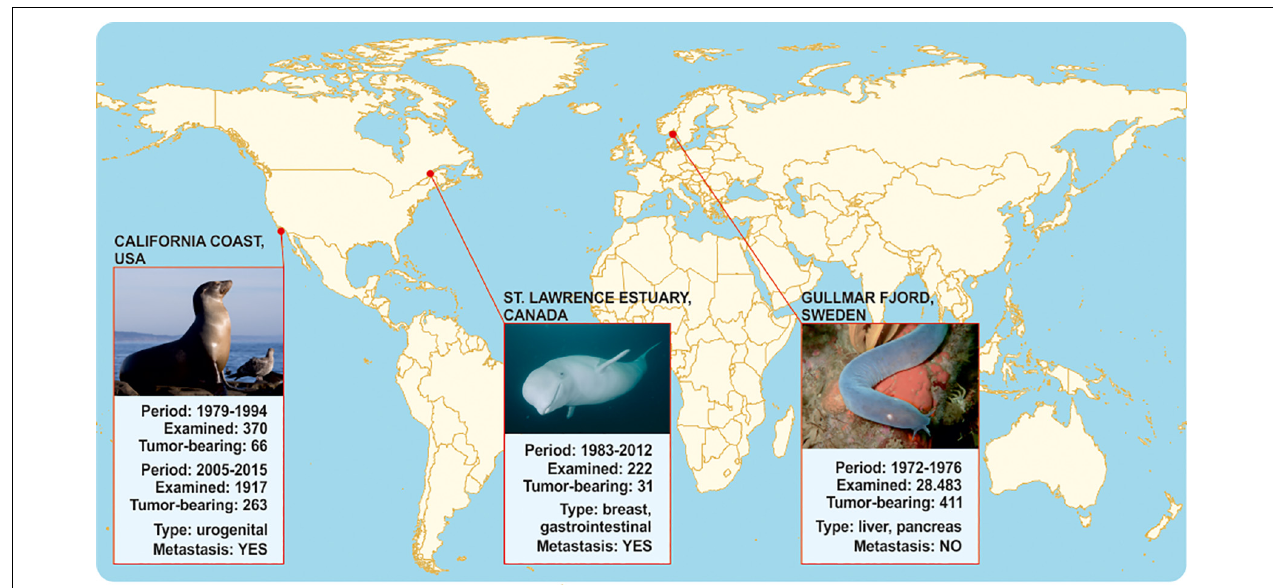
FIGURE 2 | Comparative epidemiology data on metastases in agnathan versus gnathostome representatives that inhabit comparable carcinogen-contaminated aquatic environments. No metastases have been reported in hagfishes inside and outside Gullmar fjord. On the contrary, toothed belugas in Quebec as well as California sea lions that inhabit environments polluted with similar organochlorides are susceptible to metastatic